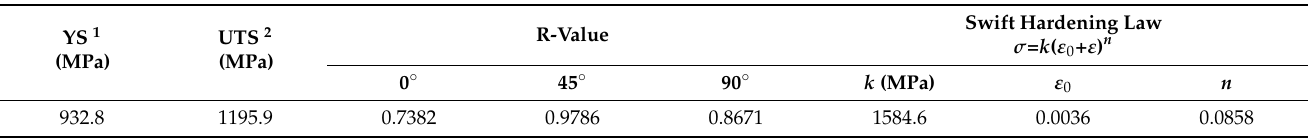
Table 1. Summary of the mechanical properties of a TRIP 1180 steel sheet obtained using uniaxial tension tests